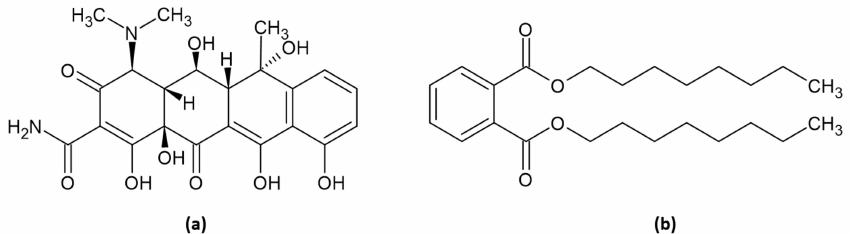
Figure 8. The chemical structures of ( a ) oxytetracyline (OTC) and ( b ) dioctyl phthalate (DOP) isolated from AC n -hexane and IC ethylacetate partitions,